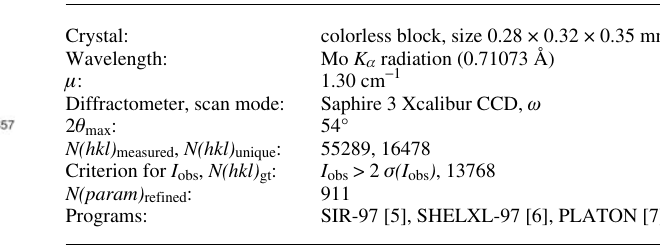
Table 1. Data collection and handling.